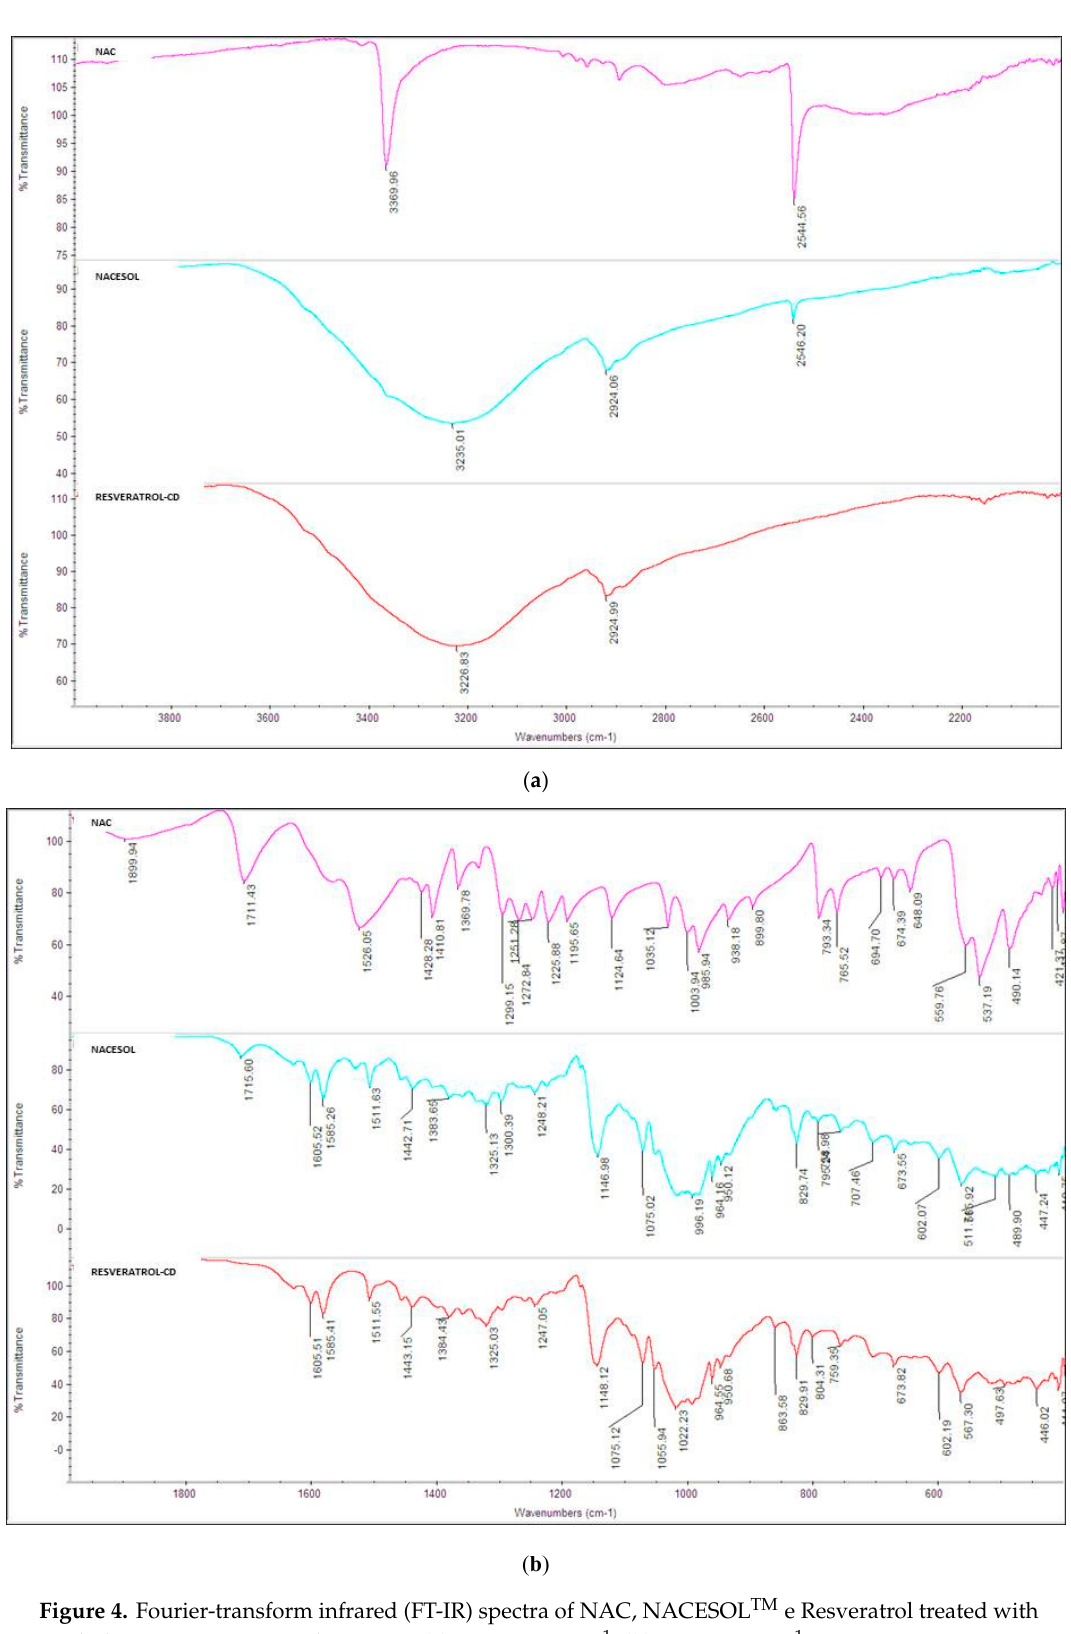
Figure 4. Fourier-transform infrared (FT-IR) spectra of NAC, NACESOL TM e Resveratrol treated with Cyclodextrin in a wavenumber range: ( a ) 4000–2000 cm − 1 ; ( b ) 2000–400 cm − 1